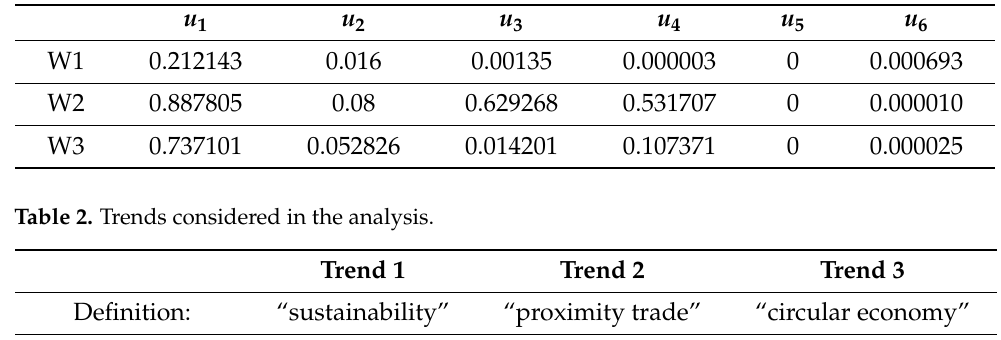
Figure 3. Semantic projections of the three selected trends on the universe U . Table 1. Elements of the Universe vs. Words of Innovative Ideas.